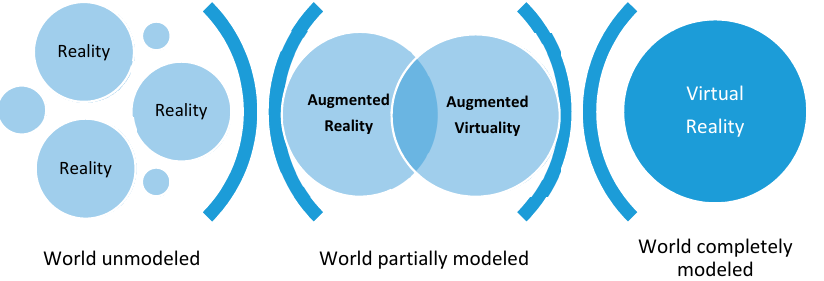
Figure 4. Augmented reality as a combination of virtual reality and the real world. Source: own elaboration based on